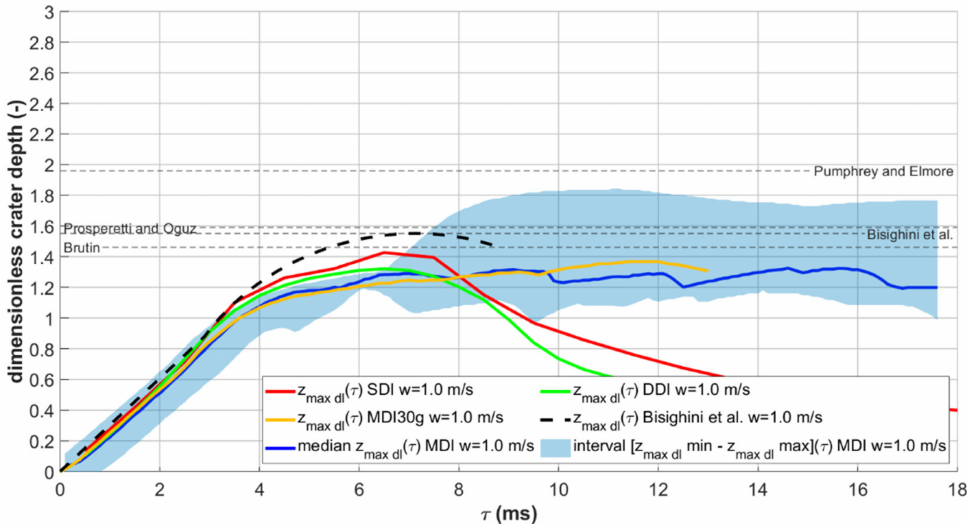
Figure 6. Dimensionless crater depth as a function of time for single, double, and multiple drop impacts at 1.0 m/s. Predictions from some of the most credited literature models are also shown.